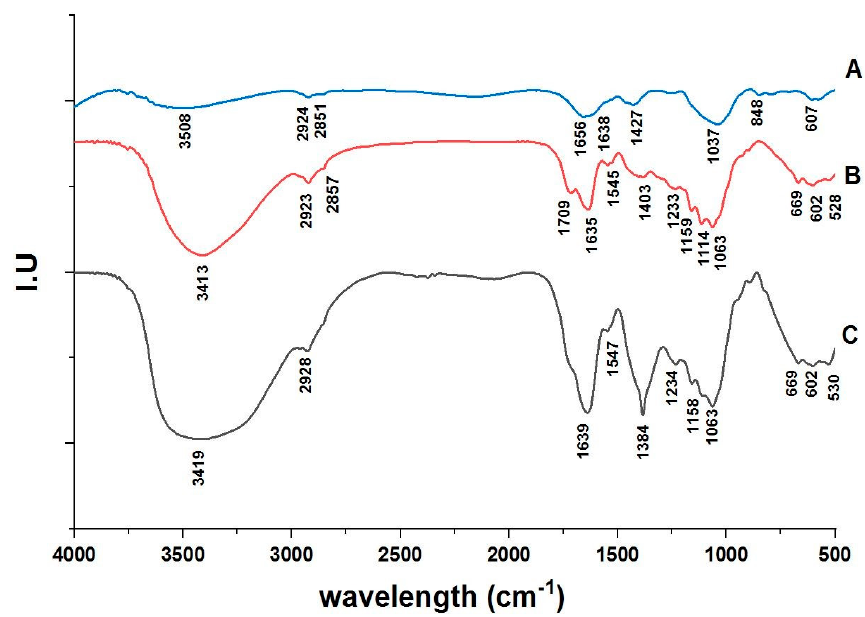
Figure 1. FT-IR spectroscopy of Ulva cellulose ( A ), Ulva nanocellulose ( B ), and Ag/Ulva cellulose nanocomposites ( C ). Table 1. Tabulated absorption peaks assigned to the active groups of cellulose (A), nanocellulose (B), and Ulva/Ag/cellulose nanocomposites (C).